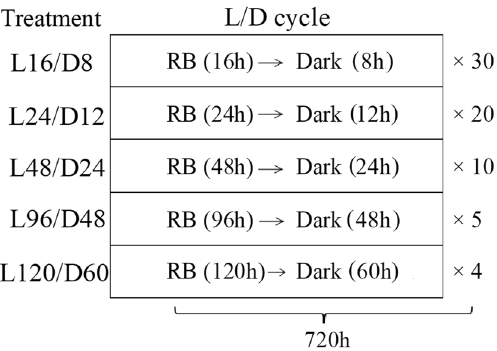
Figure 1. The irradiation modes of RB (mixed red and blue LED light, R:B = 9:1) over a 720-h growth period in different treatments. L/D—light/dark. L16/D8—16 h light/8 h dark (as control), L24/D12—24 h light/12 h dark, L48/D24—48 h light/24 h dark, L96/D48—96 h light/48 h dark, L120/D60—120 h light/60 h dark, there were respectively 30, 20, 10, 5 and 4 L/D cycles in the growth period in each